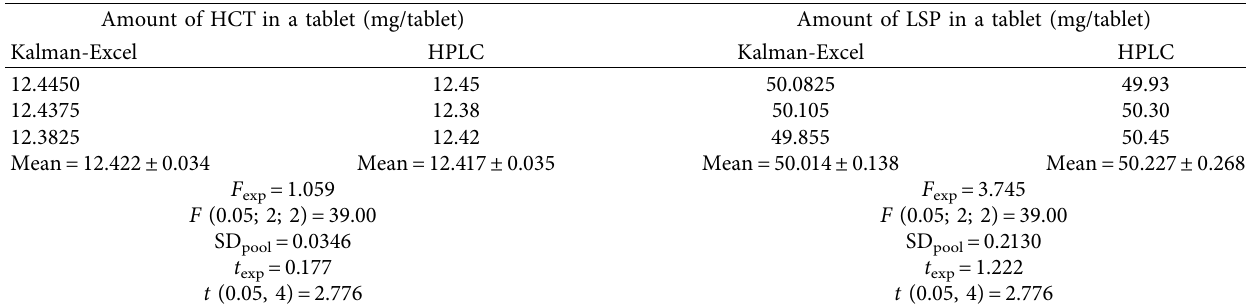
Table 5: Performance of Kalman-Excel method versus HPLC method to quantify HCT and LSP in Splozarsin Plus tablet simultaneously ( n 1 � n 2 �